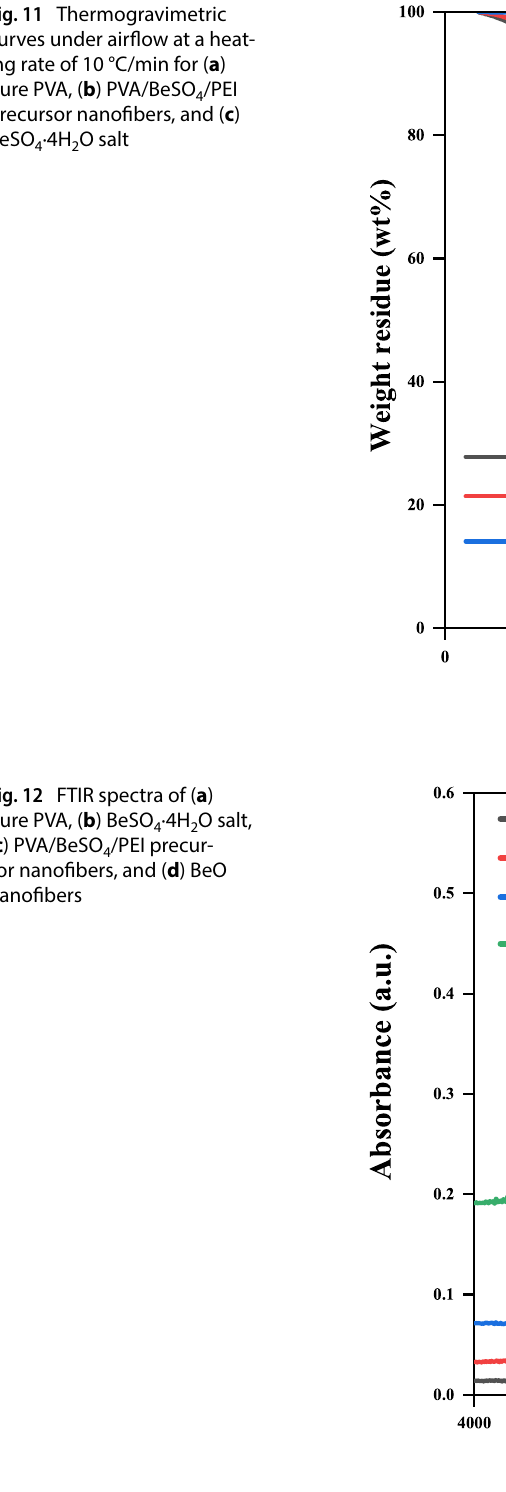
Fig. 11 Thermogravimetric curves under airflow at a heat- ing rate of 10 °C/min for ( a ) pure PVA, ( b ) PVA/BeSO precursor nanofibers, and ( c ) BeSO